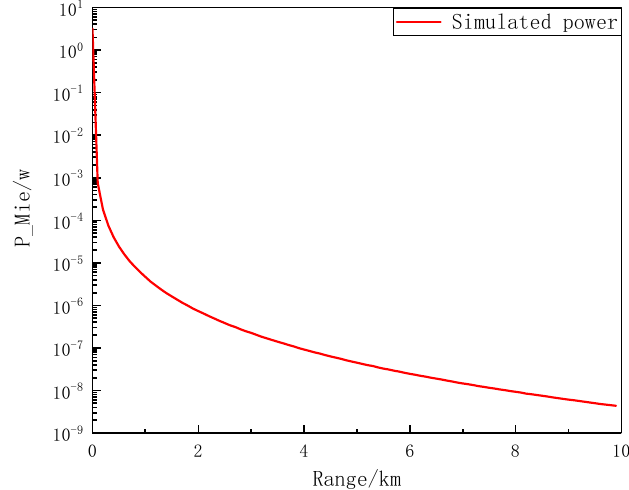
Figure 4. Theoretical return power profile of a Mie-scattering lidar.